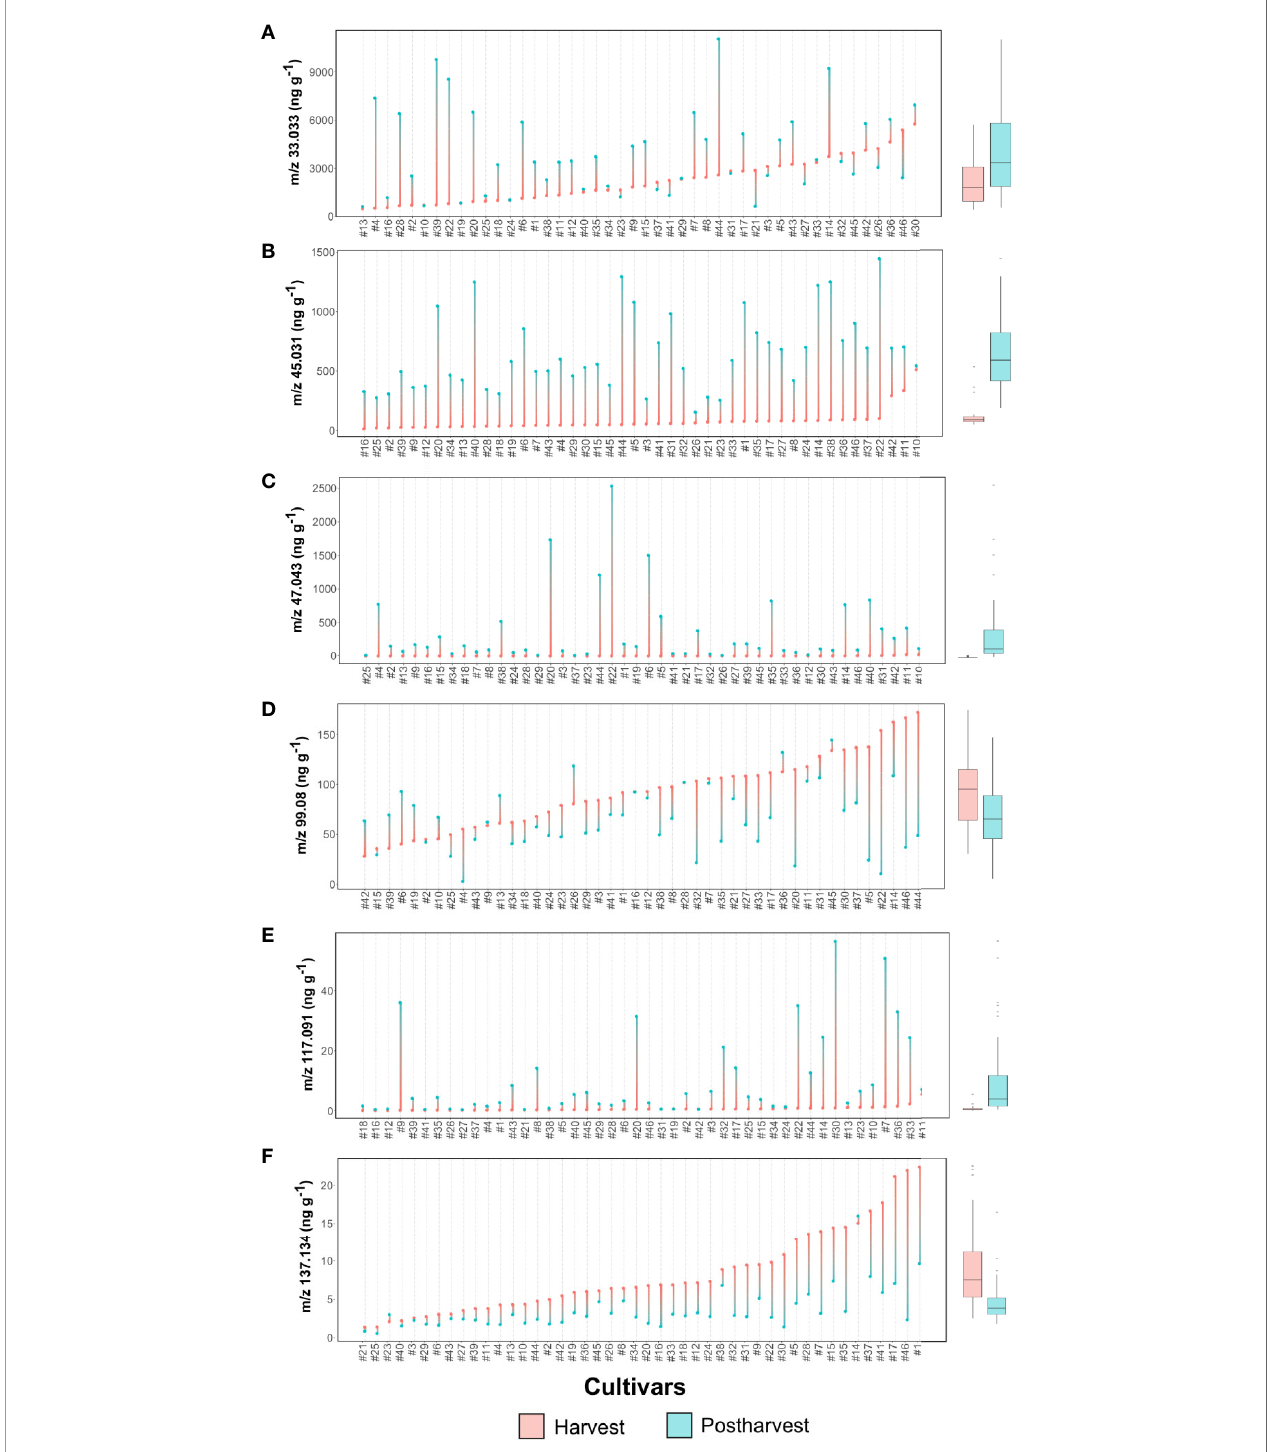
FIGURE 6 | Lollipop graph and box plot of six VOC mass peaks (out of 134 detected in total by PTR-ToF-MS: (A) m/z 33.033, (B) m/z 45.031, (C) m/z 47.043, (D) m/z 99.08, (E) m/z 117.091, (F) m/z 137.134. Each graph illustrates the average value (of three measurements) recorded at harvest and after 6 weeks of storage, for each cultivar (names of the cultivars are reported in Table 1 ). For graphical purpose, cultivars of each graph are ordered based on the trait level recorded at harvest. The box plot, reported next to each lollipop graph, summarize the differences between fruit assessed at harvest and after storage. Lollipop graphs, together with distribution plots and box plots of all 134 VOC mass peaks, are reported in Figure S4